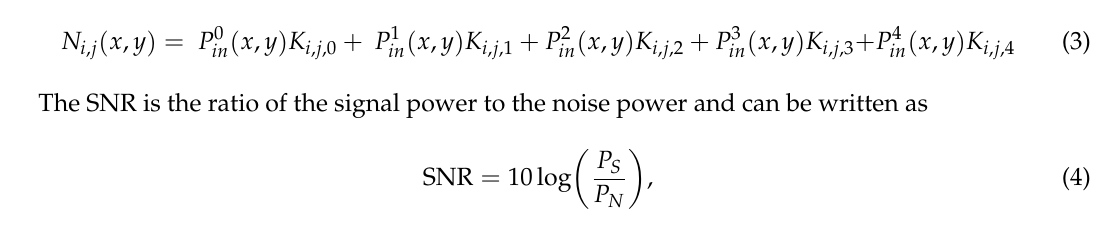
Figure 3. General optical router model.